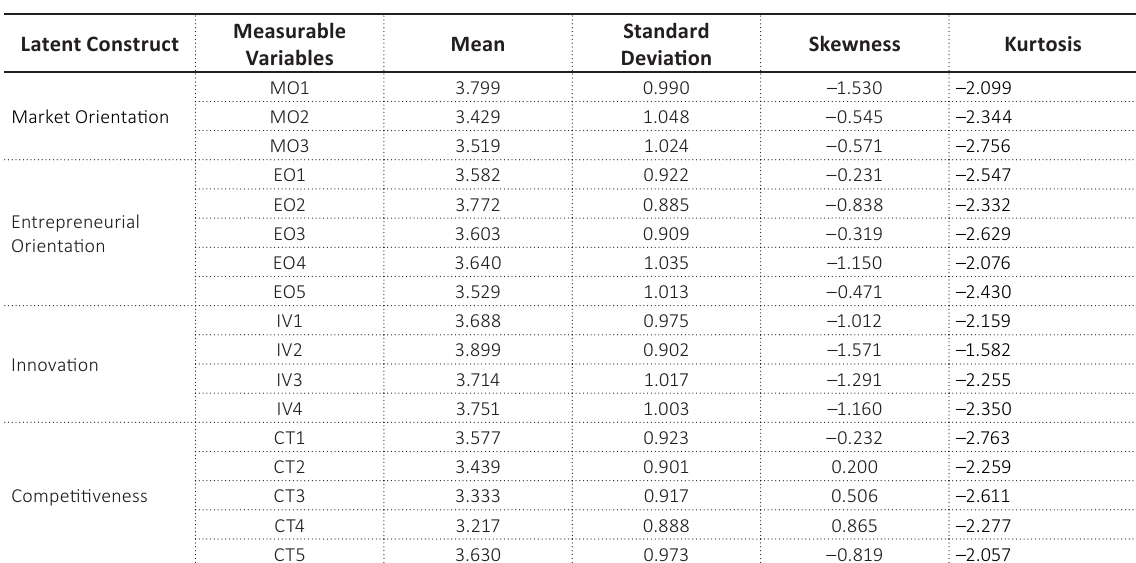
Table 2. Descriptive